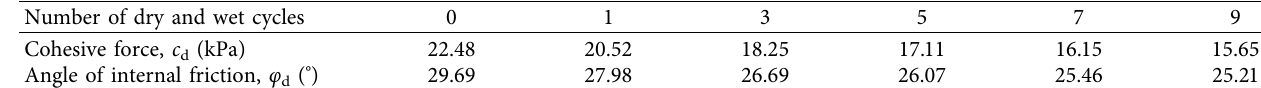
Table 6: Strength parameters of red clay under different wet and dry